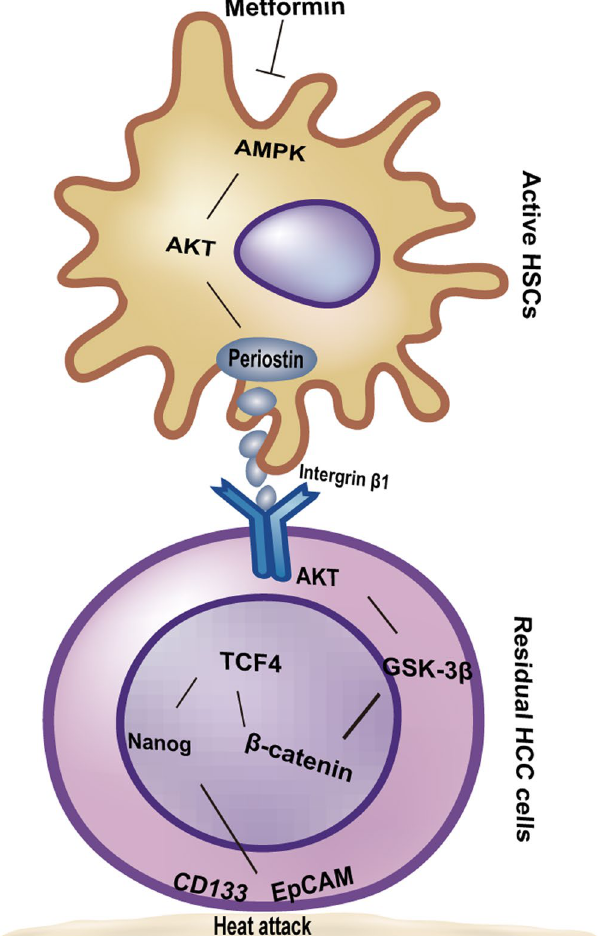
Figure 6. Graphical diagram of the proposed mechanism by which activated HSCs induced the stemness traits in heat-exposed residual HCC cells. POSTN from activated HSCs initiates integrin β 1/GSK-3 β / β -catenin/TCF4 pathway to modulate stemness traits of heat-exposed residual HCC, which was reversed by metformin via the AMPK/AKT pathway to decrease POSTN